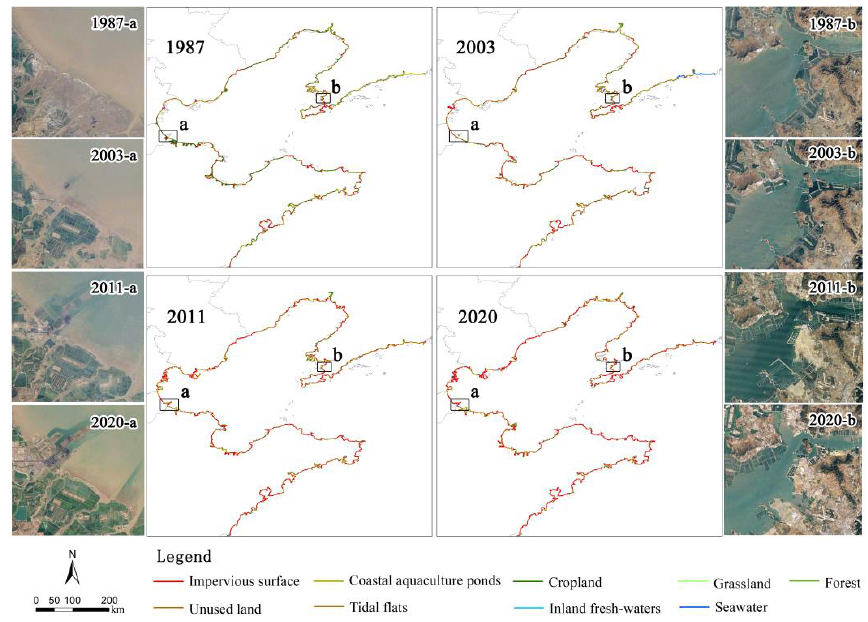
Figure 5. Distribution of changes in coastline function in the circum-Bohai coastal zone and comparison of land use change.